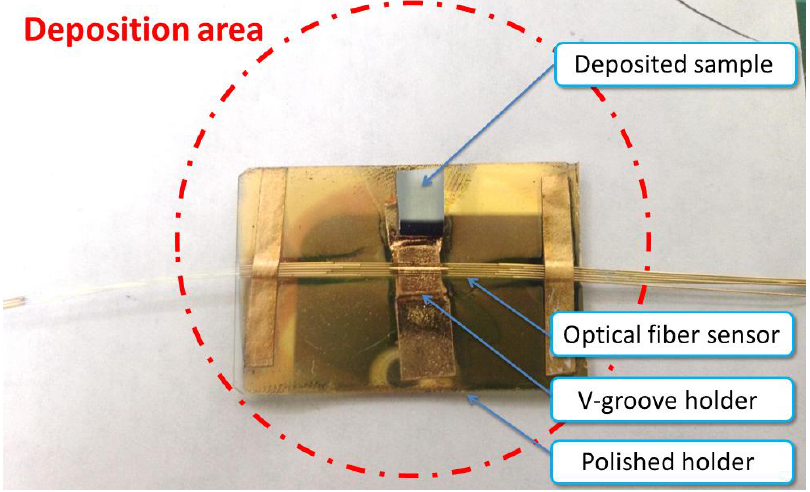
Figure 3. Deposition area and locations of the SPR optical fiber sensor and deposited